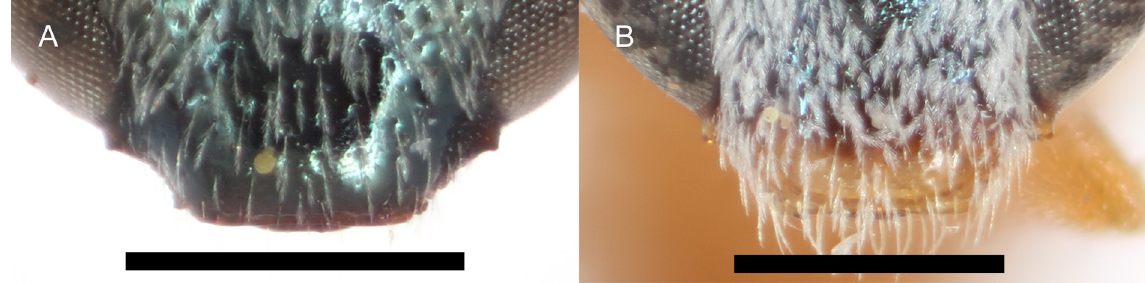
Fig. 113. Clypeus. A . Lasioglossum ( D. ) miltolepoides sp. nov., ♂, sparsely punctate and entirely metallic. B . L. ( D. ) arenisaltans sp. nov., ♂, with dense punctures and yellow-orange apical rim. Scale bars: 0.5